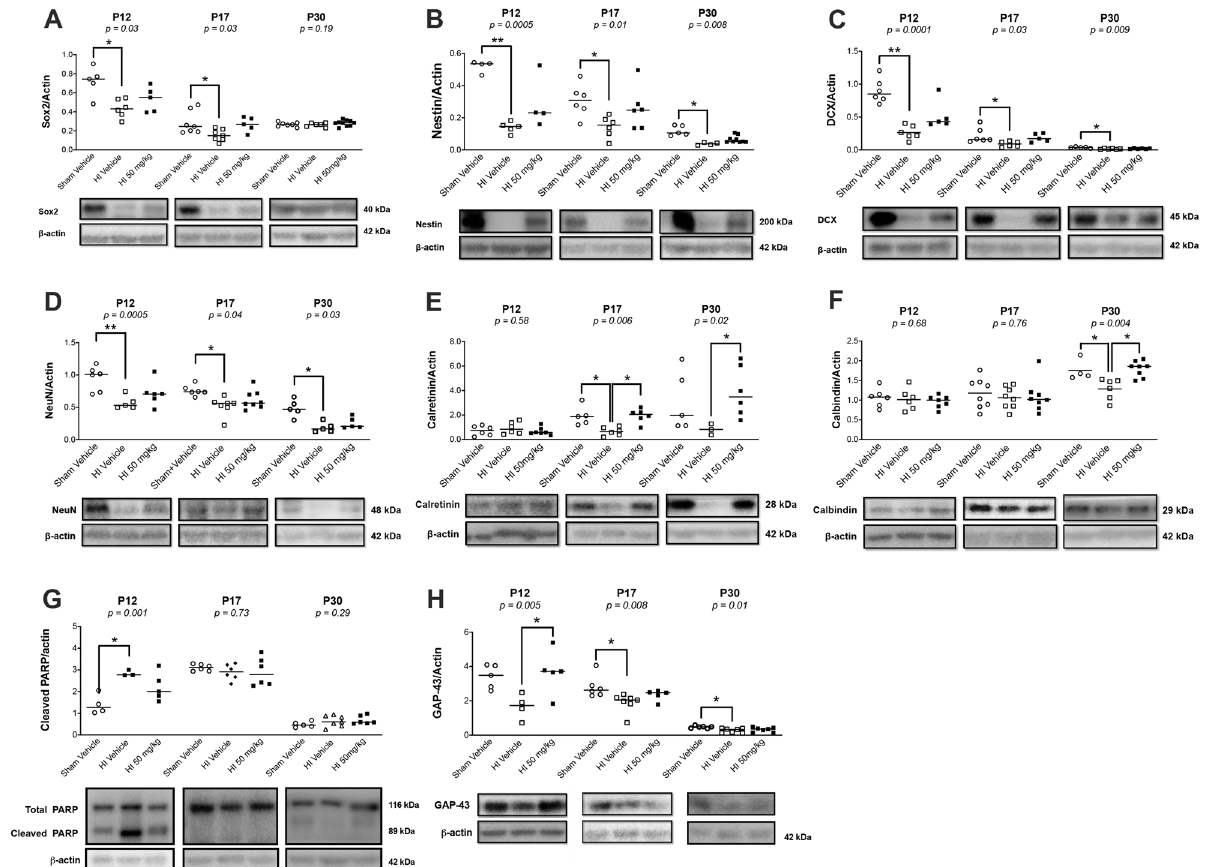
Figure 3. Western blotting for markers of early/late neuronal development, apoptosis, and axonal regeneration of the ipsilateral hippocampus in sham and HI rat pups treated with vehicle or sildenafil. Median with individual data points representation, with cropped representative western blots. Full-length blots are presented in Supplementary Material. ( A ) Sox2. ( B ) Nestin. ( C ) Doublecortin (DCX). ( D ) NeuN. ( E ) Calretinin. ( F ) Calbindin. ( G ) Cleaved PARP. ( H ) GAP-43. Significance: p value from Kruskal–Wallis test, with Dunn’s post- hoc comparison tests: * p < 0.05, ** p < 0.01. Number of animals: n = 6, 8 and 7 sham vehicle, 6, 8 and 7 HI vehicle, and 7, 8 and 10 HI 50 mg/kg, respectively at P12, P17 and